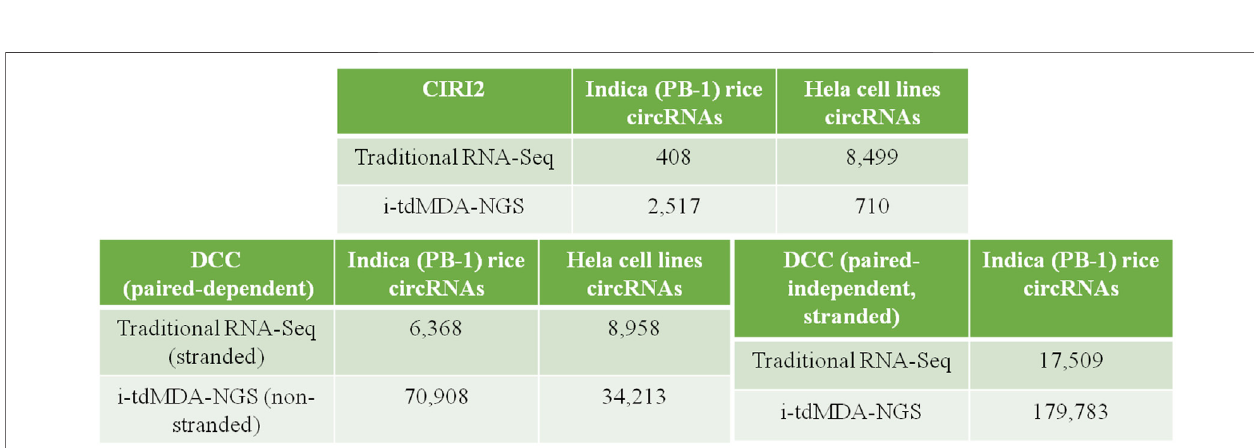
Frontiers in Molecular Biosciences |